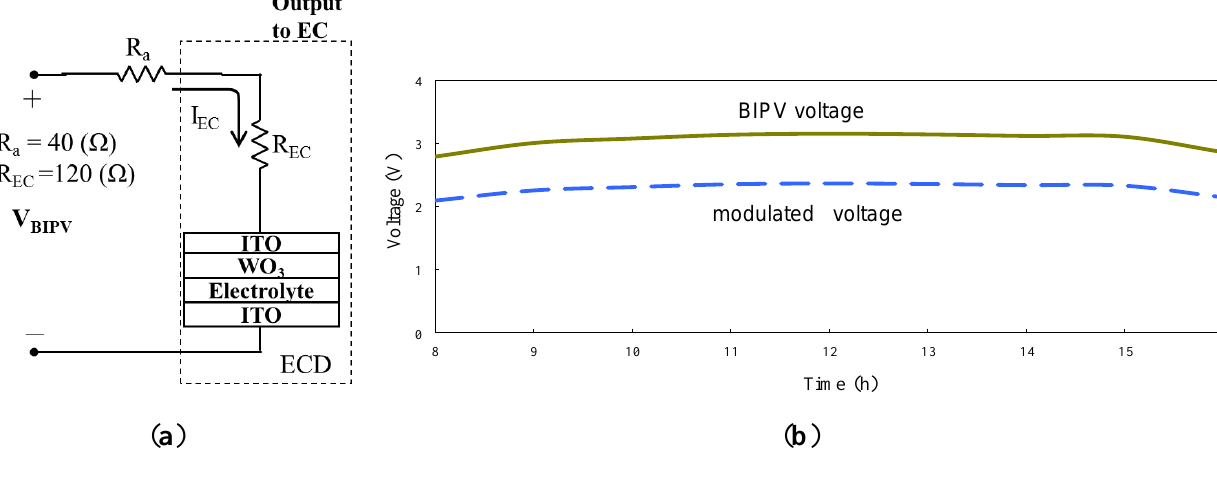
Figure 13. Variations of original indoor illuminance ( upper ) and controlled